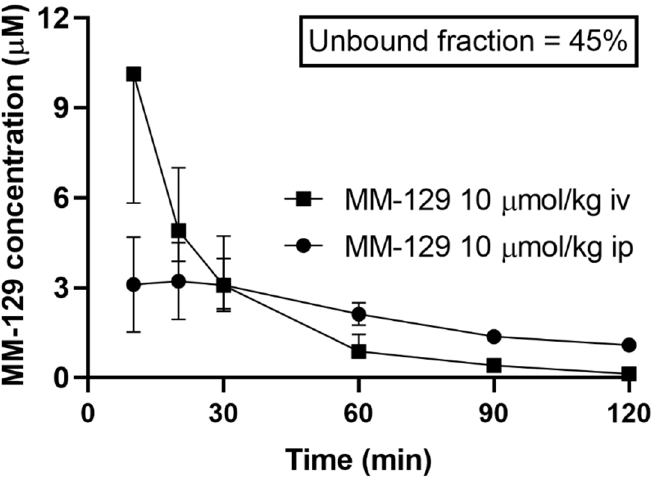
Figure 6. Pharmacokinetics curves of MM-129 in rats’ plasma. Results are presented as a median with lower and upper limits. Abbreviations: MM-129—pyrazolo[4,3-e]tetrazolo[4,5-b][1,2,4]triazine sulfonamide; iv, intravenous; ip; intraperitoneal.